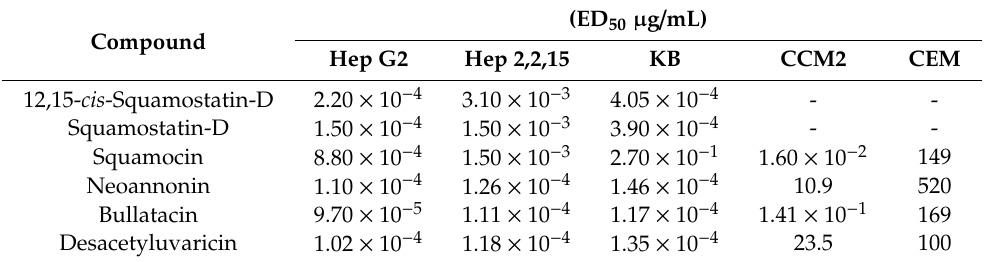
Table 2. Isolated pure compounds from A. atemoya and their cytotoxic activities [20].